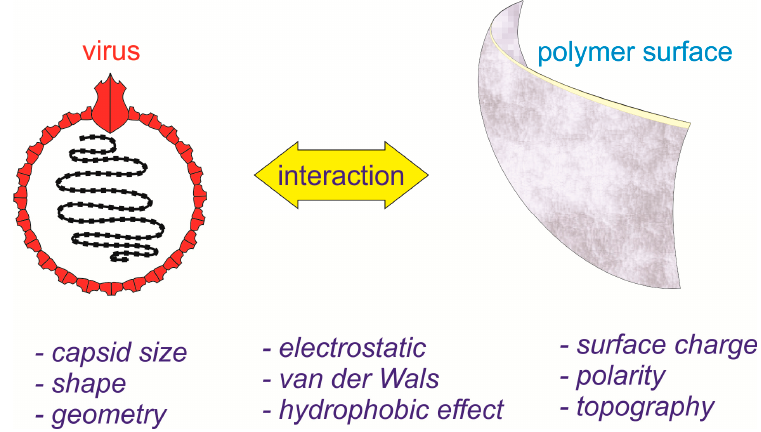
Figure 6. Tuning polymer-specific properties to enhance filtration efficiency and virus ineffectuality.